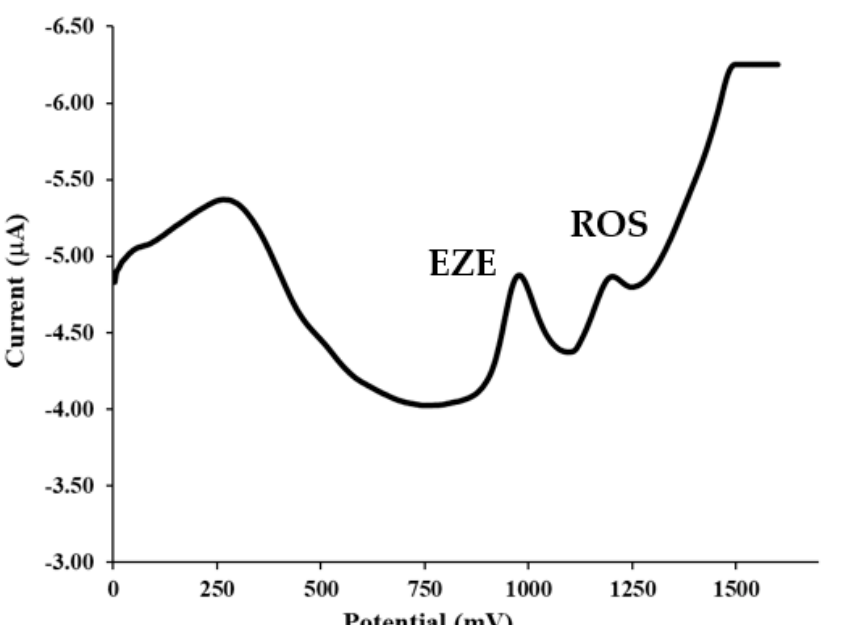
Figure 1. The AdSDPV voltammograms of 5.0 × 10 − 6 M EZE and 7.5 × 10 − 6 M ROS in 0.1 M H 2 SO 4 (stripping conditions: accumulation potential of 0.0 V and accumulation time of 15 s).